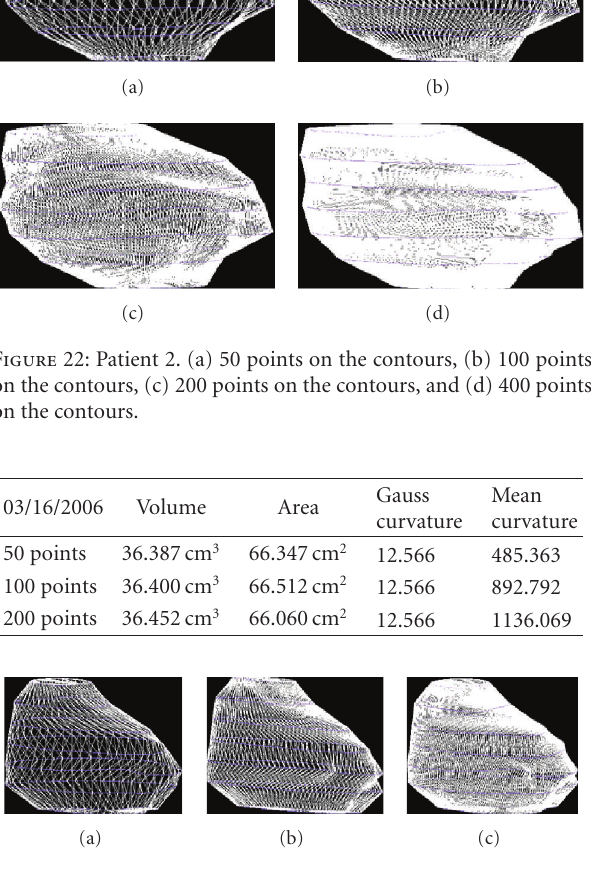
Figure 23: Patient 2. (a) 50 points on the contours, (b) 100 points on the contours, and (c) 200 points on the